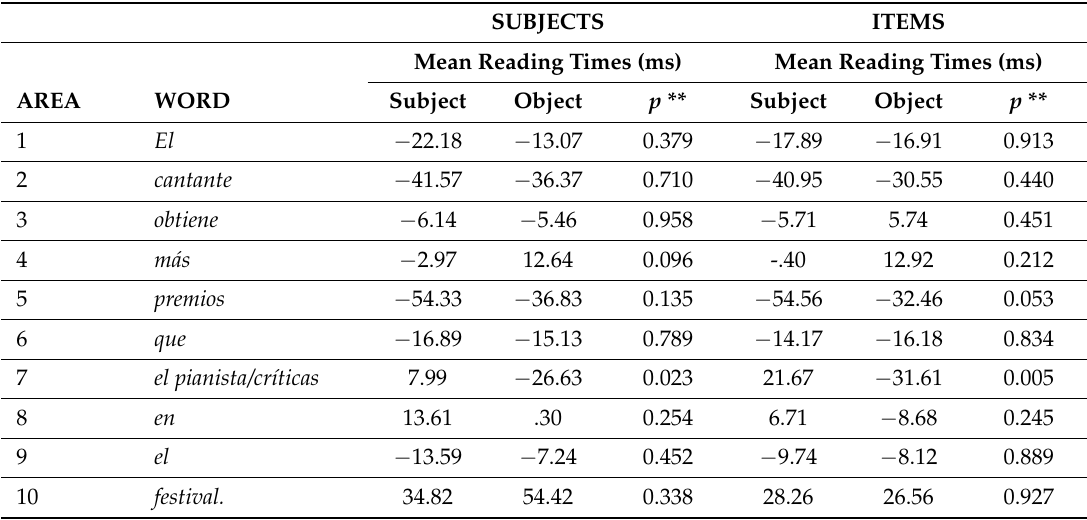
Table 4. Residual reading times of Type of Continuation in milliseconds